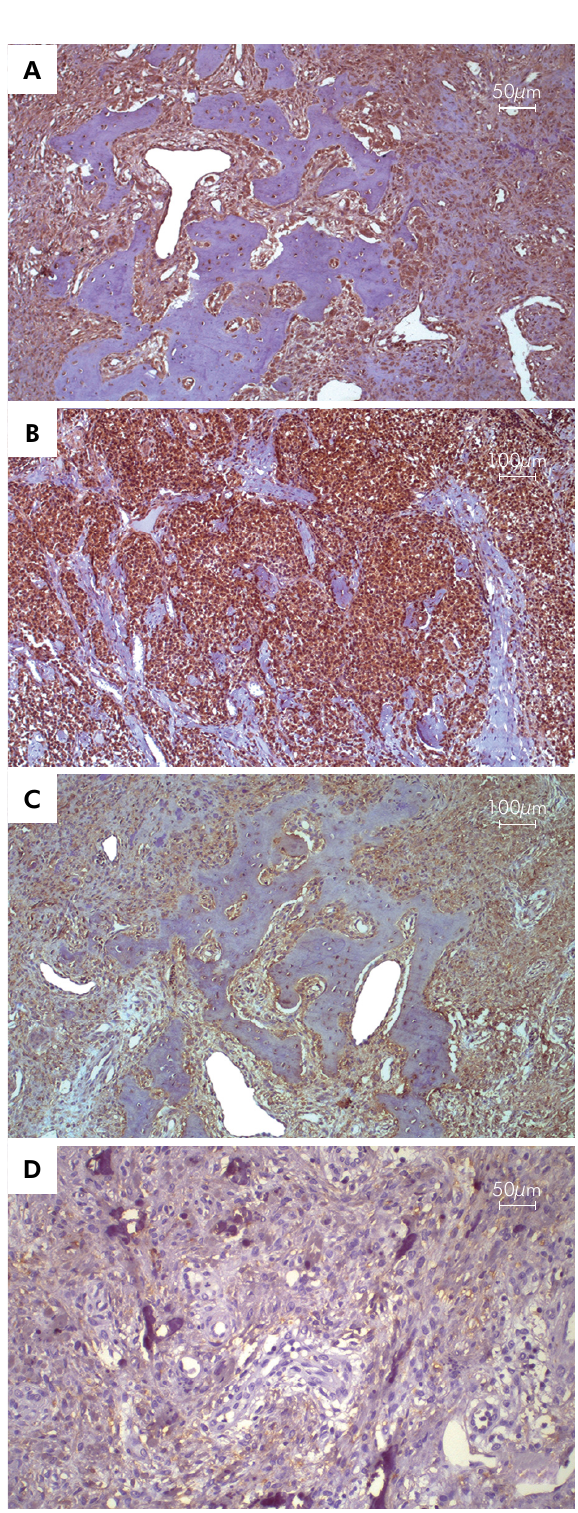
Figure 4. Photomicrographs: OSX indicating spindle-shaped cells around the mineralized tissue (4A) and OSX high immunopositivity in the cell-rich tissue (4B). STRO-1, indicating spindle-shaped cells around the mineralized tissue (4C) and negative stainning g of STRO-1 (4D). Mayer`s hematoxylin counterstain.